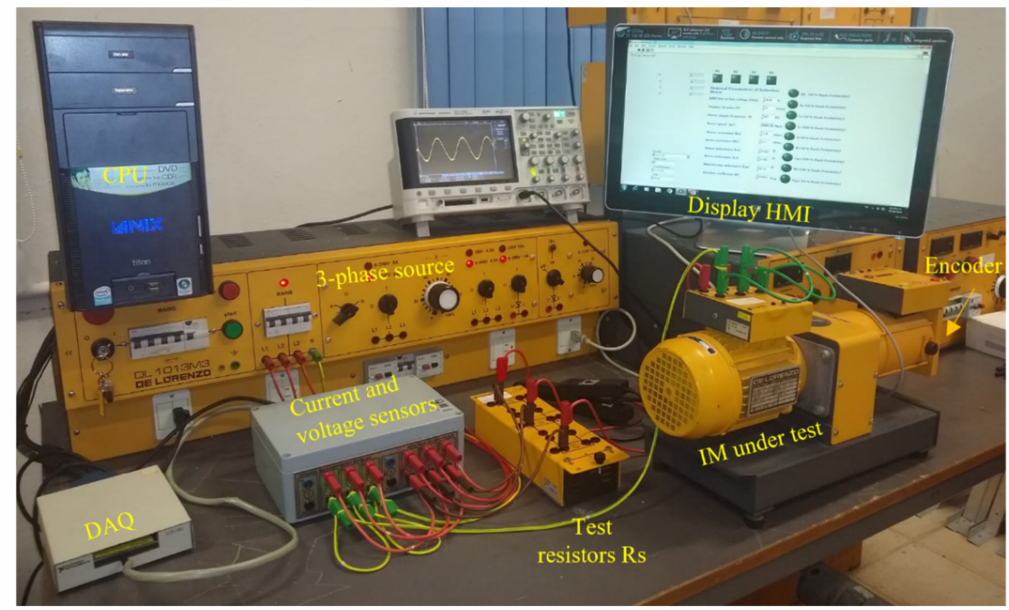
Figure 9. Photograph of experimental